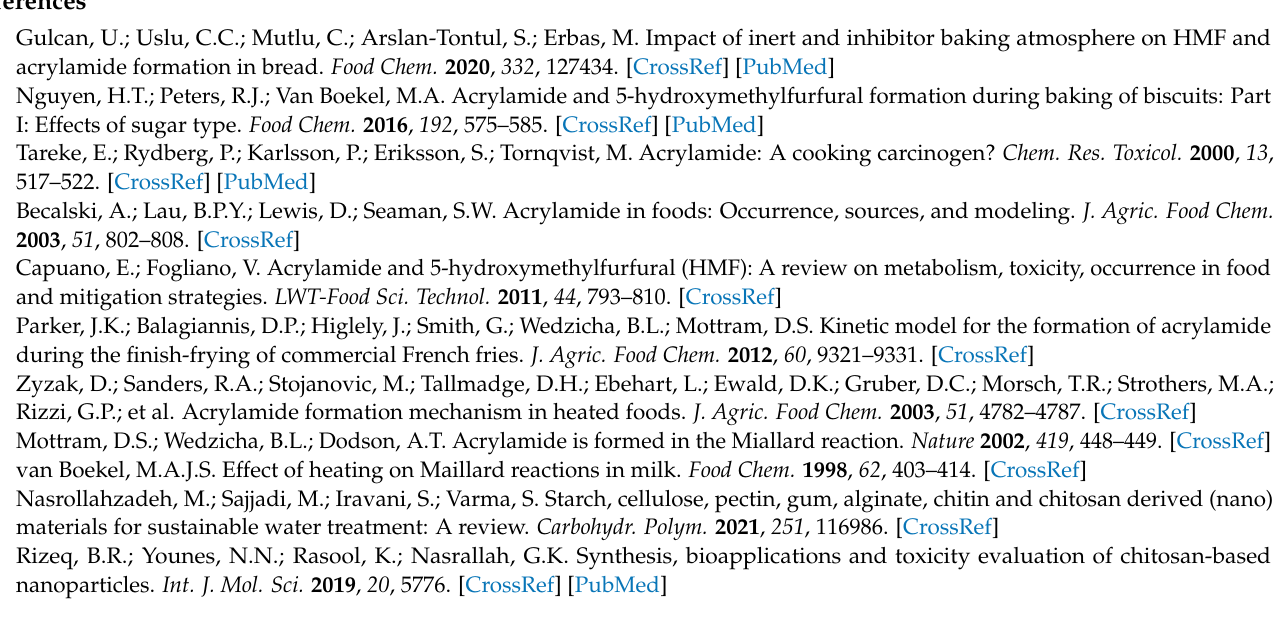
the glucose groups. Table S2: The correlation of addition chitosan between kinematic viscosity, intermediate product, final product, CIELAB color difference and antioxidant activity in the glucose groups. Table S3: The correlation of different heating time between kinematic viscosity, intermediate product, final product, CIELAB color difference and antioxidant activity in the fructose groups. Table S4: The correlation of addition chitosan between kinematic viscosity, intermediate product, final product, CIELAB color difference and antioxidant activity in the fructose groups. Figure S1: Appearance change during 30 min heating in aqueous